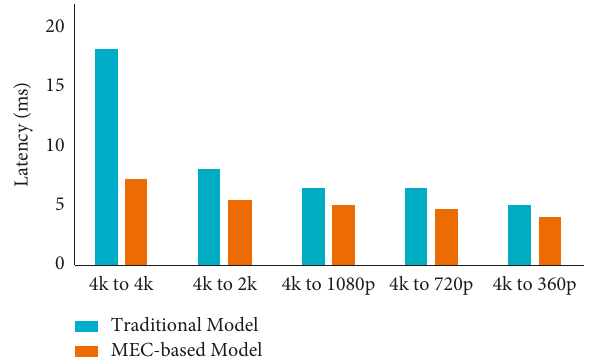
Figure 9: Code rate conversion delay analysis under different